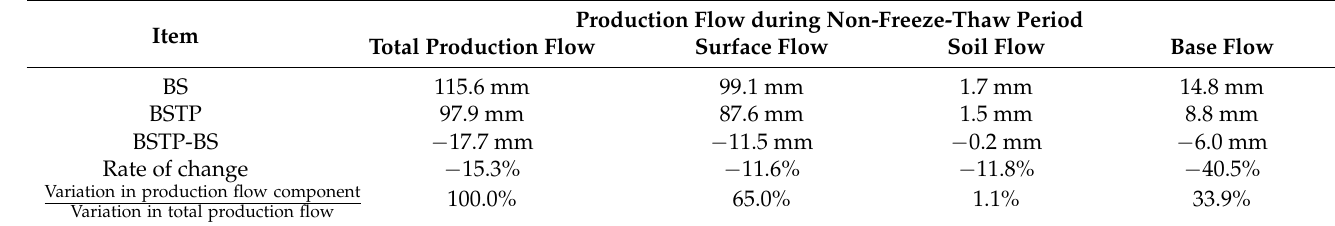
Table 11. Influences of temperature and precipitation on the variation in runoff component during the non-freeze-thaw period.